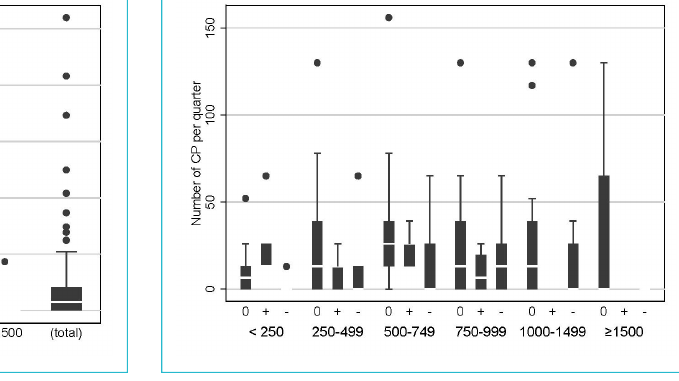
Table 2: Number of patients with paediatric chronic pain (PCP) seen and estimation of PCP prevalence. Number of patients with PCP seen in the last 7 days (n = 203) Mean = 1.58 (SD = 2.21); sum over all pediatricians = 322 Number of patients with PCP seen in the last 7 days: representative? (n = 205)